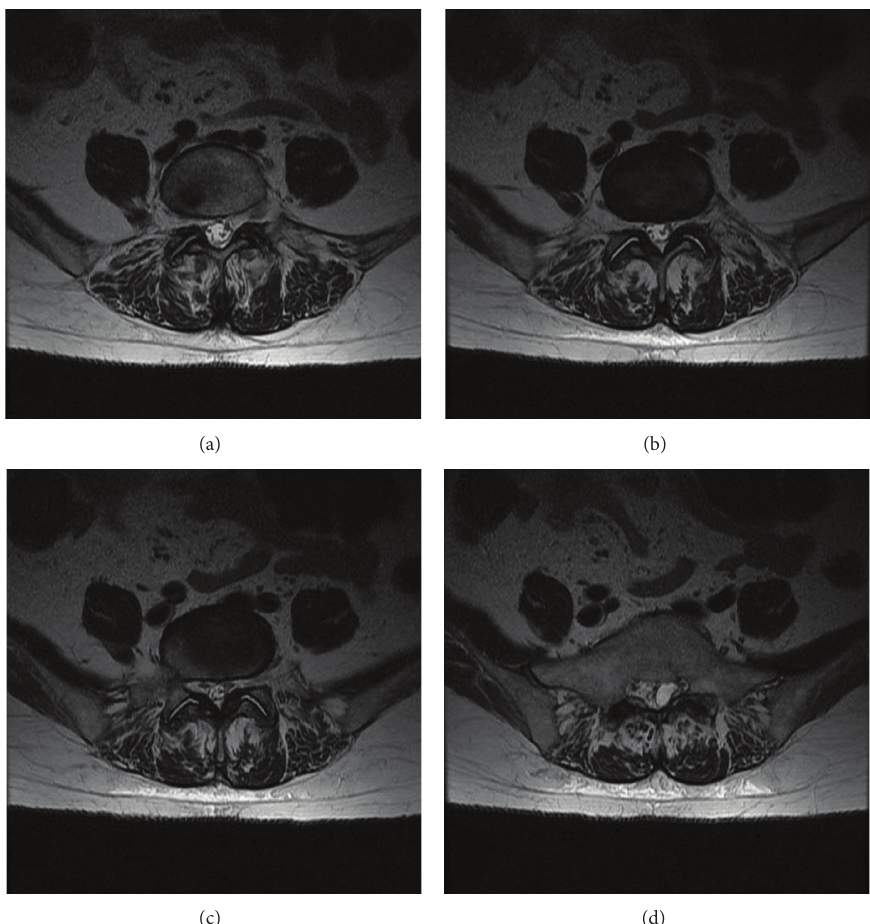
Figure 2: Axial T2-weighted MRI images showing sequential cuts ((a)–(d)) inferiorly from the L5-S1 facet joint showing an intrasacral mass separate from the L5-S1